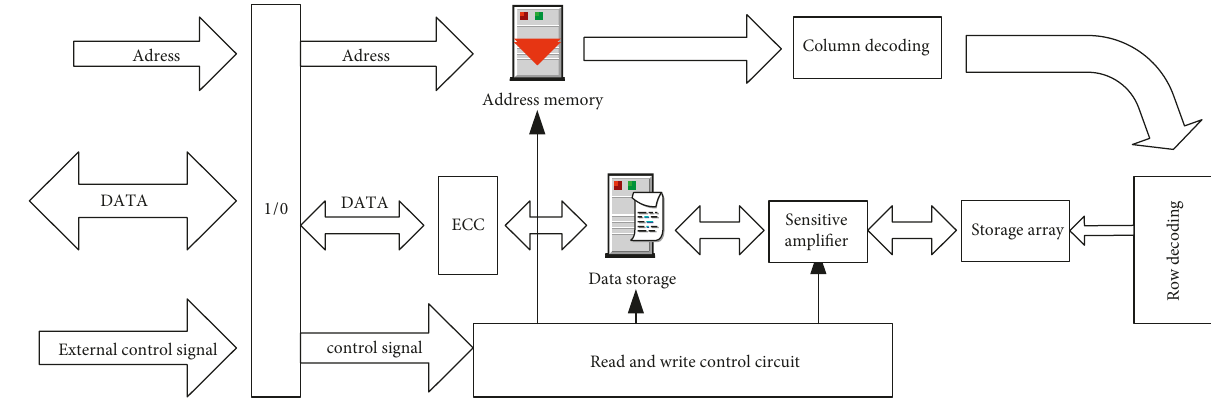
Figure 2: Circuit flow diagram of ferroelectric